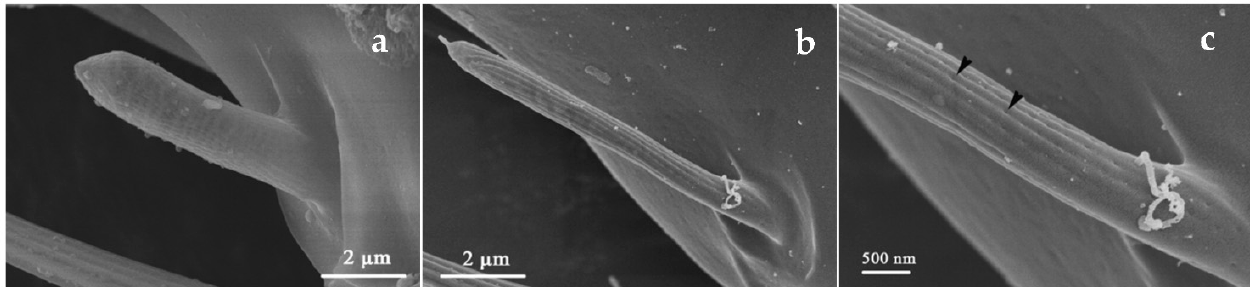
Figure 4. Sensilla basiconica II (SBII) on the flagellum II of O. loti ( a ) and S. kaszabi ( b ). A high-resolution of SBII is shown in ( c ). Holes (indicated by the black arrows) are distributed evenly between longitudinal ridges but with a smaller density than that of sensilla basiconica I (SBI).